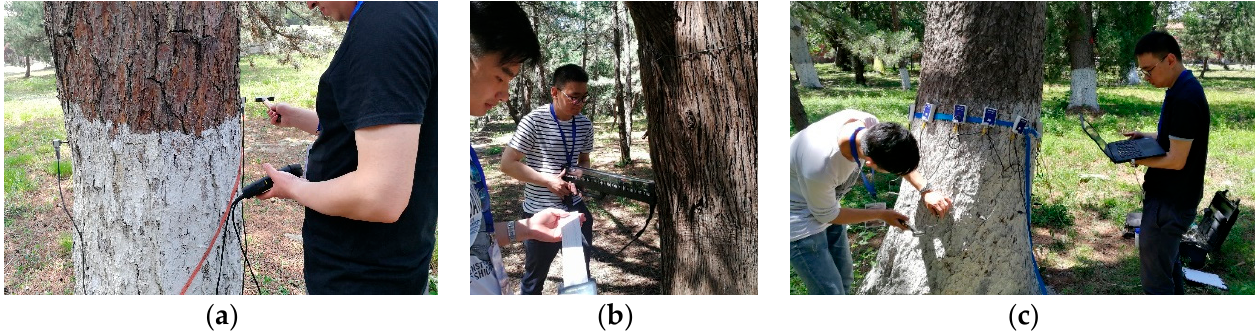
Figure 1. Field inspection of tree trunk’s internal defects: ( a ) stress wave transmission velocity method, ( b ) Resistograph measurement, and ( c ) a stress wave tomography measurement [45].